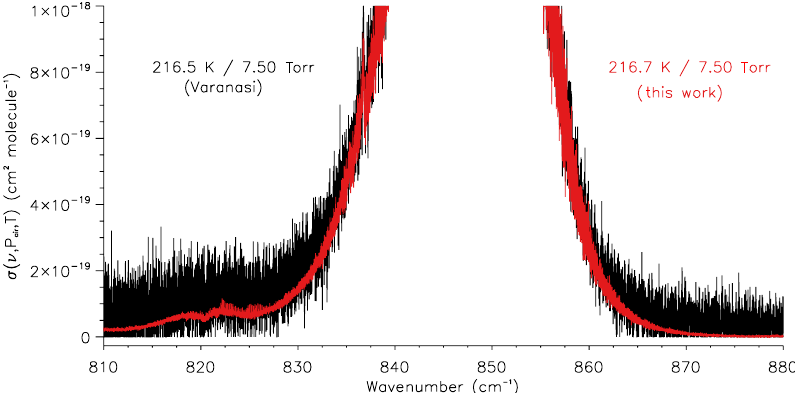
Figure 5. The Varanasi absorption cross section of trichlorofluoromethane/dry synthetic air at 216.5K and 7.50Torr (black), with the new cross section at 216.7K and 7.50Torr overlaid (red; this work). Additional noise in the Varanasi cross section is clearly visible.